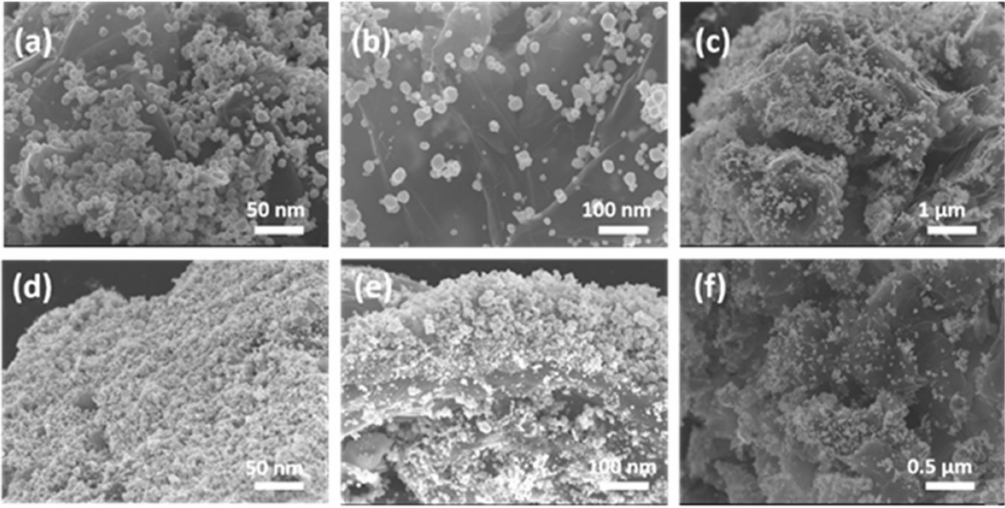
Figure 3. SEM images of the RGO/Cu/Cu 2 O composite.